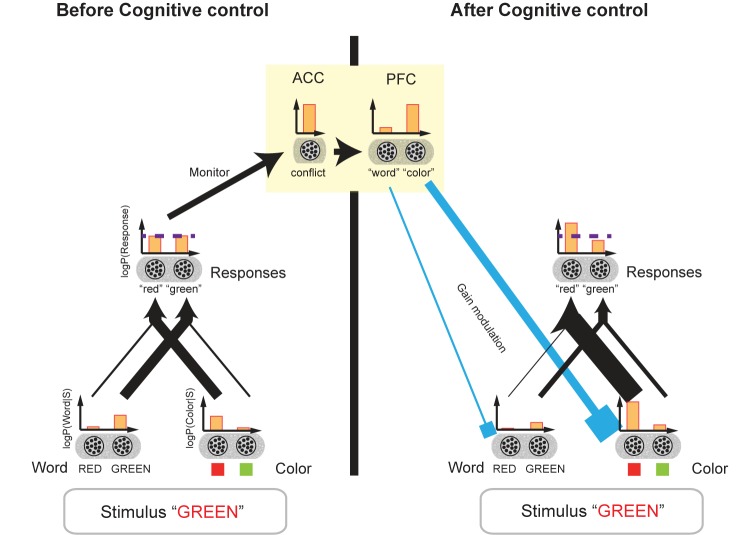
Biased Bayesian inference and cognitive control. The network model of cognitive control for the Stroop task (Botvinick et al., 2001) is shown. This model can be considered a network model of biased Bayesian inference. The bar graphs indicate the mean firing rates of the neural populations, and their outputs to the target populations is indicated by the connecting arrows’ thickness which is consistent with the firing rates. Before cognitive control, when the stimulus [“GREEN” in red ink color ((incongruent) in this example)] is presented, word-encoding neurons and color-encoding ones in the perception layer are activated (r(RED) < r(GREEN), r(green link); r(●) being the mean firing rate of the population). We assume that these neurons encode the log-likelihoods of the word and color of the presented stimulus. The perception layer sends output to the response layer. The incongruent stimulus, “GREEN” printed in red, activates not only the neurons encoding “green” but also the neurons encoding “red” in the response layer. Then, the firing rates of the two types of neurons should be close to each other r(“red”) = r(“green”); the horizontal dashed line indicates the original level of the firing rates]. (If the congruent stimulus, “GREEN” printed in green, for example, were presented, the firing rates of the two types of neurons should be distinctively different from each other.) We assume the neurons in the response layer encode the prior/posterior distribution of the responses. The comparable firing rates of the neurons encoding different responses are considered a conflict, which thus activates the ACC. The ACC then sends the cognitive control demand signal to the PFC (yellow square). In turn, the PFC regulates the gains of word- and color-encoding neurons by sending a top–down signal (cyan input), which corresponds to regulation of bias levels (βword,βcolor) in our biased Bayesian inference. The top–down signal augments the gains of neurons encoding task-relevant information (color encoding neurons in this example), and then the firing rates of the two types of neurons in the response layer (“green,” “red”) begin to differ in accordance with the task requirements. Thus, the appropriate response is achieved.